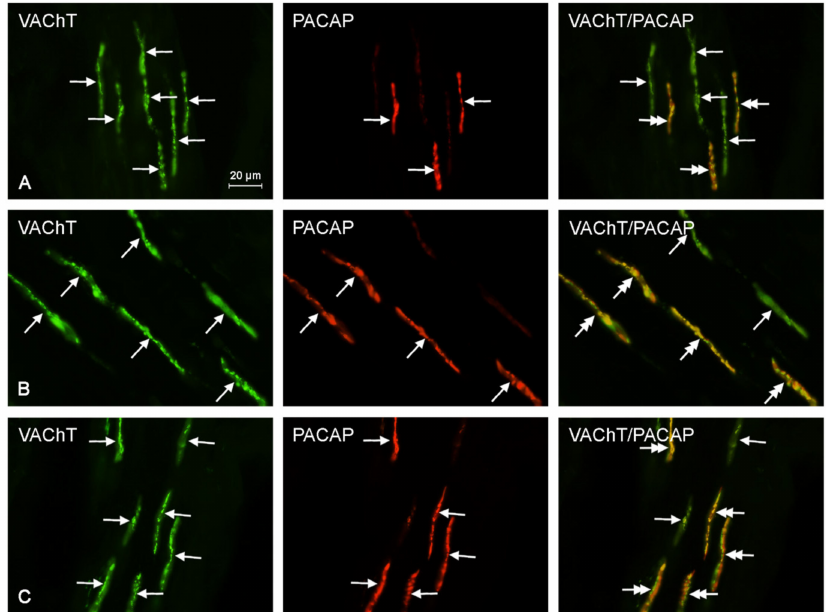
Figure 6. Representative images of immunocytochemical localization of VAChT- and PACAP-immunoreactive nerve fibers in intrahepatic sympathetic nerves (arrows) of the control (CTRL; ( A )), E1—experimental group 1 (low dose of bisphenol A; ( B )), and E2—experimental group 2 (high dose of bisphenol A, ( C )); VAChT or PACAP-IR nerve fibers are indicated with arrows, VAChT and PACAP-IR nerve fibers are indicated with double-headed arrows; scale bars in all figures; 20 µ